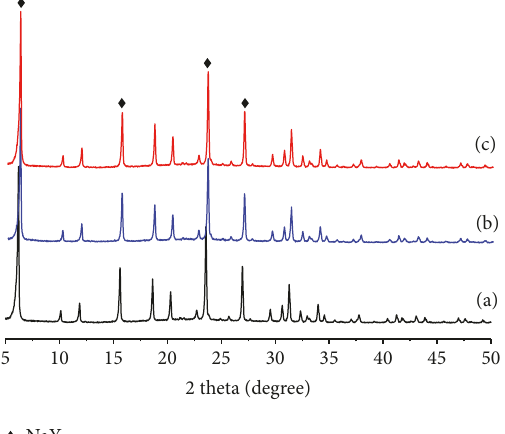
Figure 5: XRD spectra of fresh and reused NaY catalysts. (a) Fresh NaY; (b) NaY after used for the first time; (c) NaY after used for the second